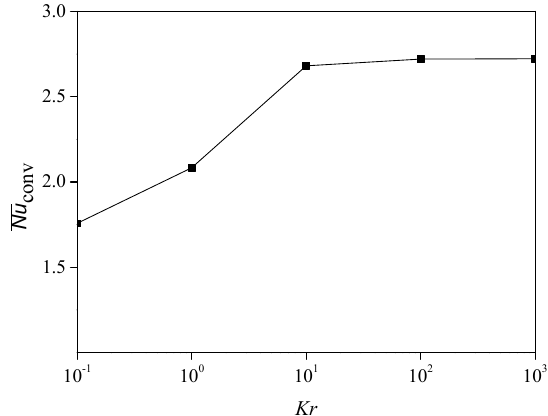
Figure 6. Variations of the average Nusselt number as a function of Kr.